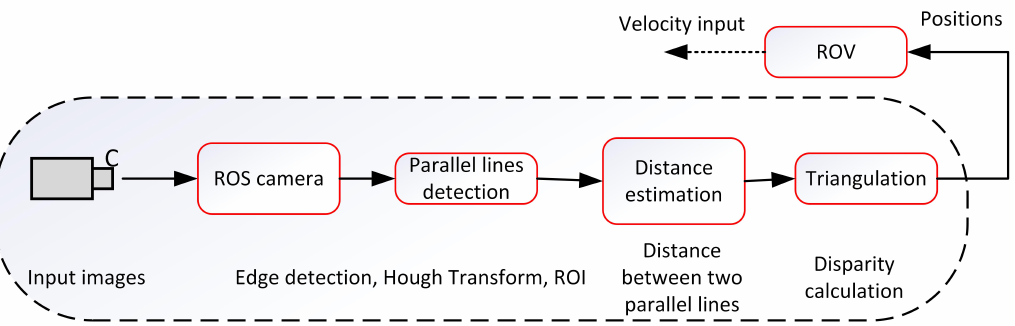
Figure 6. Method 2. Monocular image design scheme for positioning and auto-inspection of the underwater fish cage net adopted from [21].